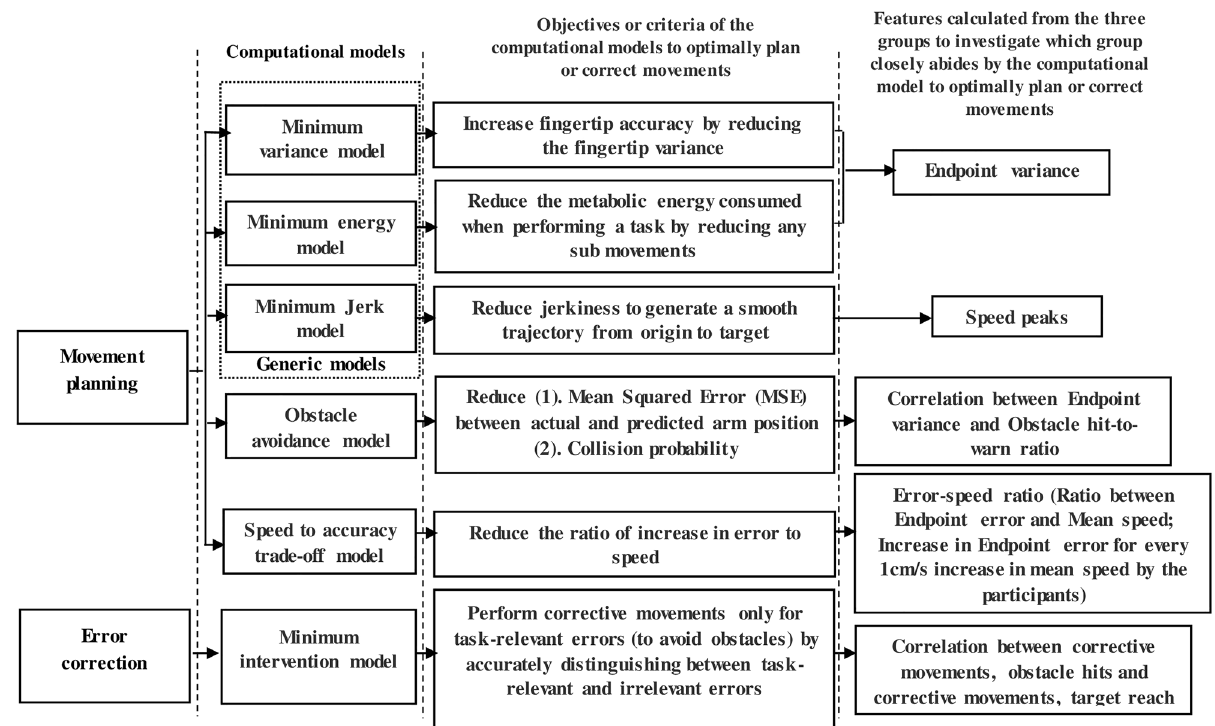
Figure 3. Computational models and features extracted to compare the performance of the groups. Features were extracted from the three groups and compared with each other to determine which group performs the best based on the objectives or criteria proposed by the computational